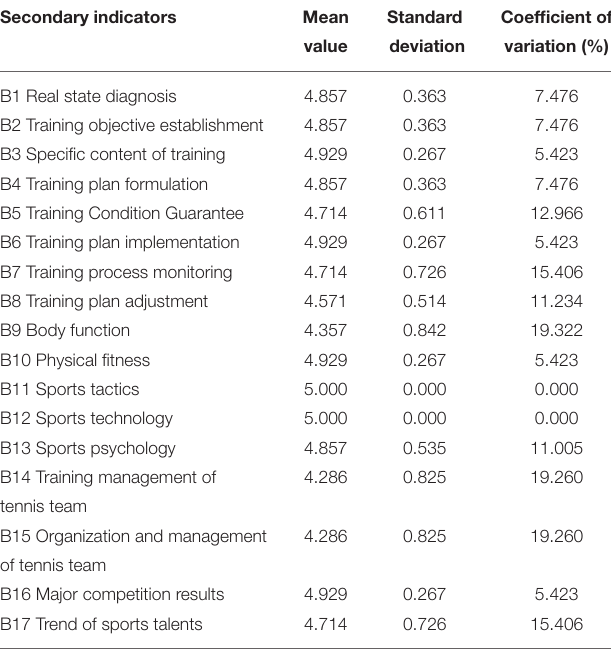
TABLE 11 | Survey results of secondary index experts. Secondary